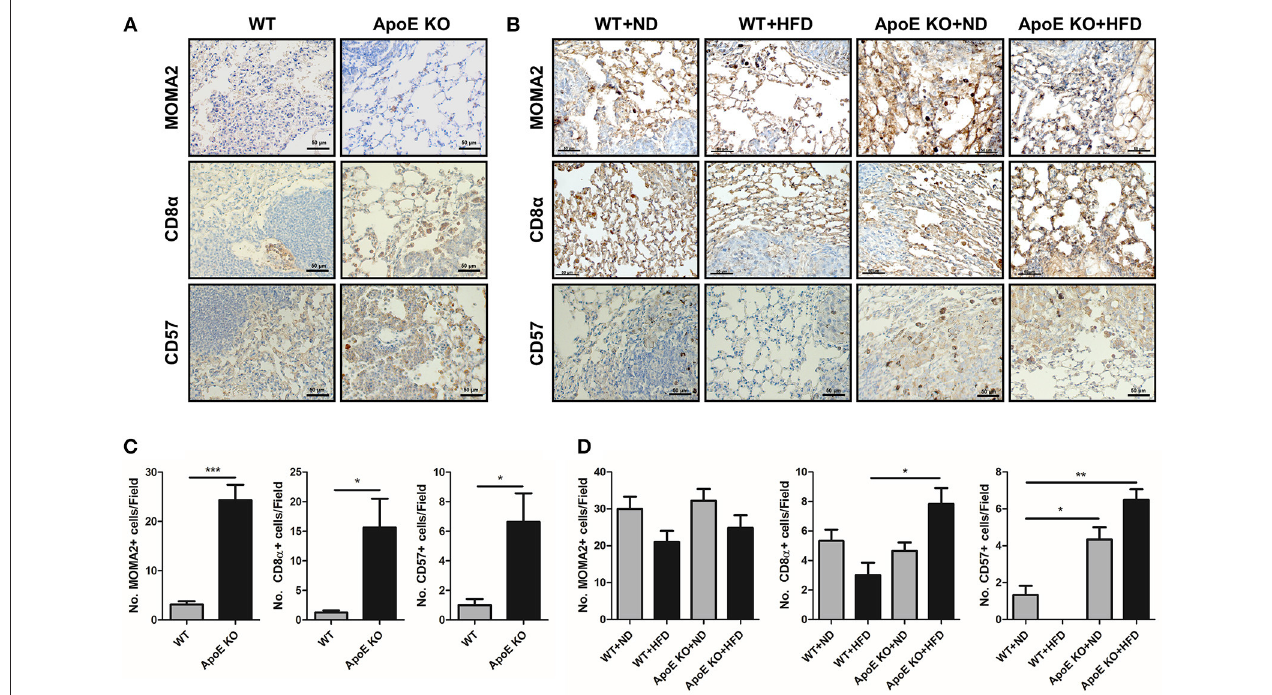
FIGURE 4 | Effect of ApoE KO on the infiltration of immune cells into urethane-induced lung tumor tissues and B16F10 lung metastasis tissues. (A,B) Representative immunohistochemical images showing MOMA2 (for monocytes/macrophages), CD8 α (for cytotoxic CD8T cells) and CD57 (for NK cells) positive cells in the urethane-induced lung tumor tissues (A) and B16F10 lung metastasis tissues (B) from WT and ApoE KO mice. Scale bar, 50 µ m. (C,D) Bar graphs represent infiltrated cells in tumor area. * p < 0.05, ** p < 0.01, and *** p <